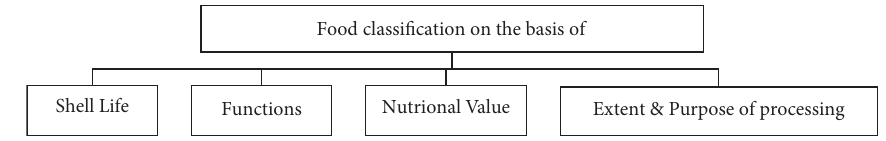
Figure 1: Classification of food preservation.